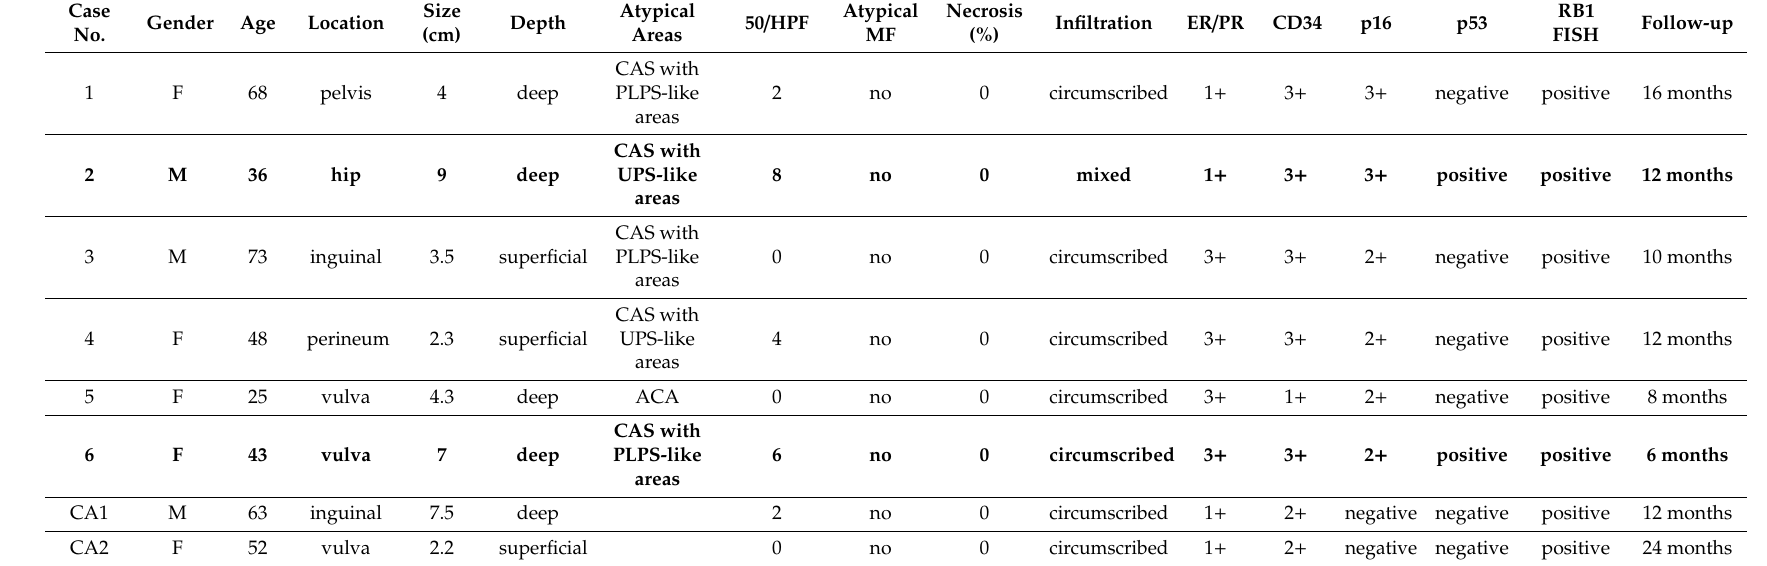
Bold letters represent the p53 positive cases. CA: cellular angiofibroma, ACA: atypical angiofibroma, CAS: angiofibroma with sarcomatous transformation, PLPS: pleomorphic liposarcoma, UPS: undi ff erentiated pleomorphic sarcoma, ER / PR: xxx, FISH: fluorescence in situ hybridization; 1 + , 2 + , and 3 + indicate mild, moderate, and strong positivity by immunohistochemical